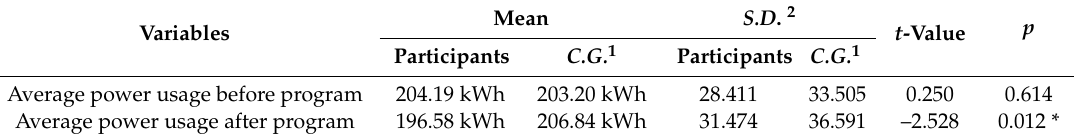
Table 5. Comparison of Energy Saving Rate Before and After Program with control